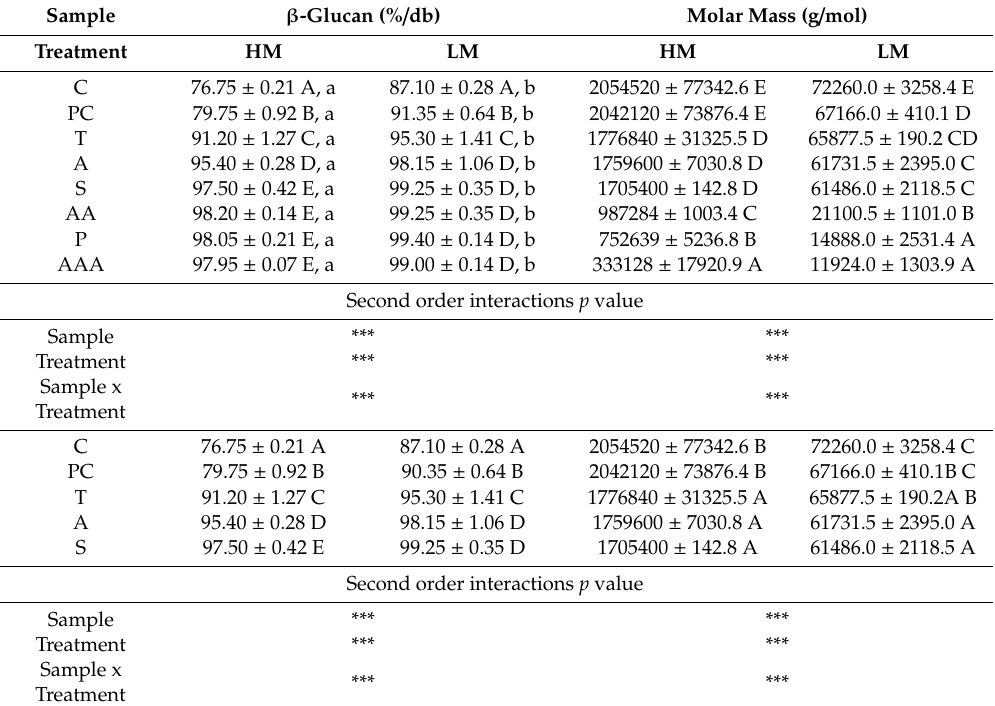
Table 3. Proteinaceous residuals content in obtained β -glucan